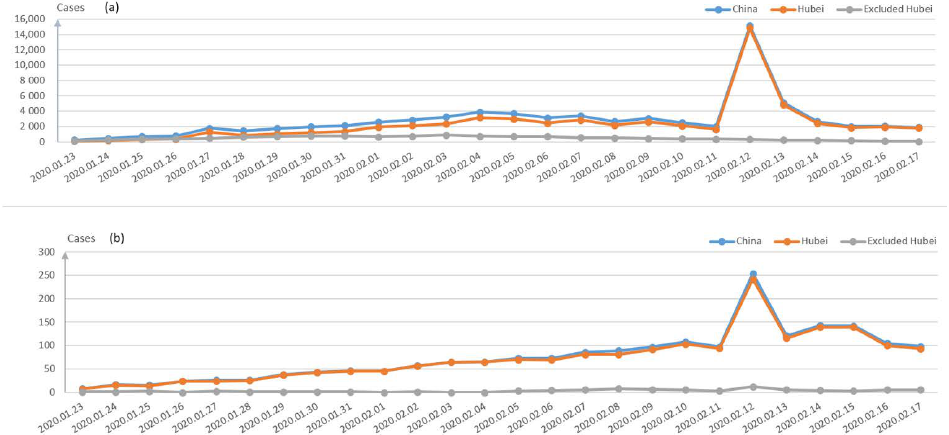
Figure 5. ( a ) The daily new confirmed cases in China, Hubei and non-Hubei provinces; ( b ) The daily new death cases of China, Hubei and non-Hubei